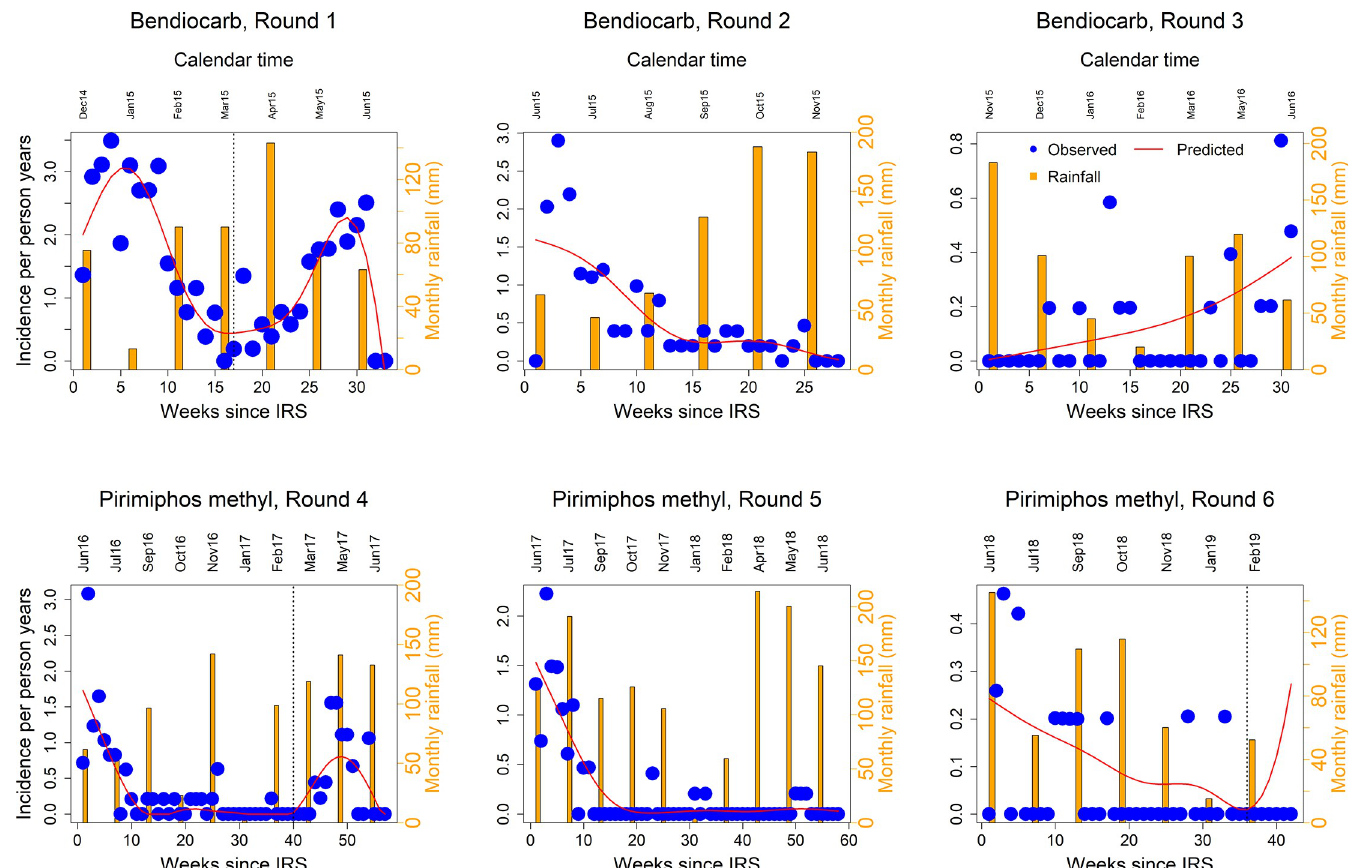
Fig 3. Observed (blue points) and predicted (solid red line) incidence of malaria per person-years against time in weeks since application of IRS and monthly rainfall (vertical orange bars) against calendar time for each round of bendiocarb (top row) and pirimiphos methyl (bottom row). The secondary y-axis labelled in orange represents the amount of monthly rainfall in mm. The vertical dotted lines indicate optimal time for applying another round of IRS.